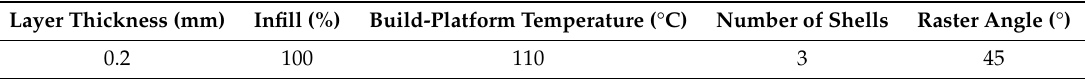
Table 1. Parameters used for the 3D printing of the test